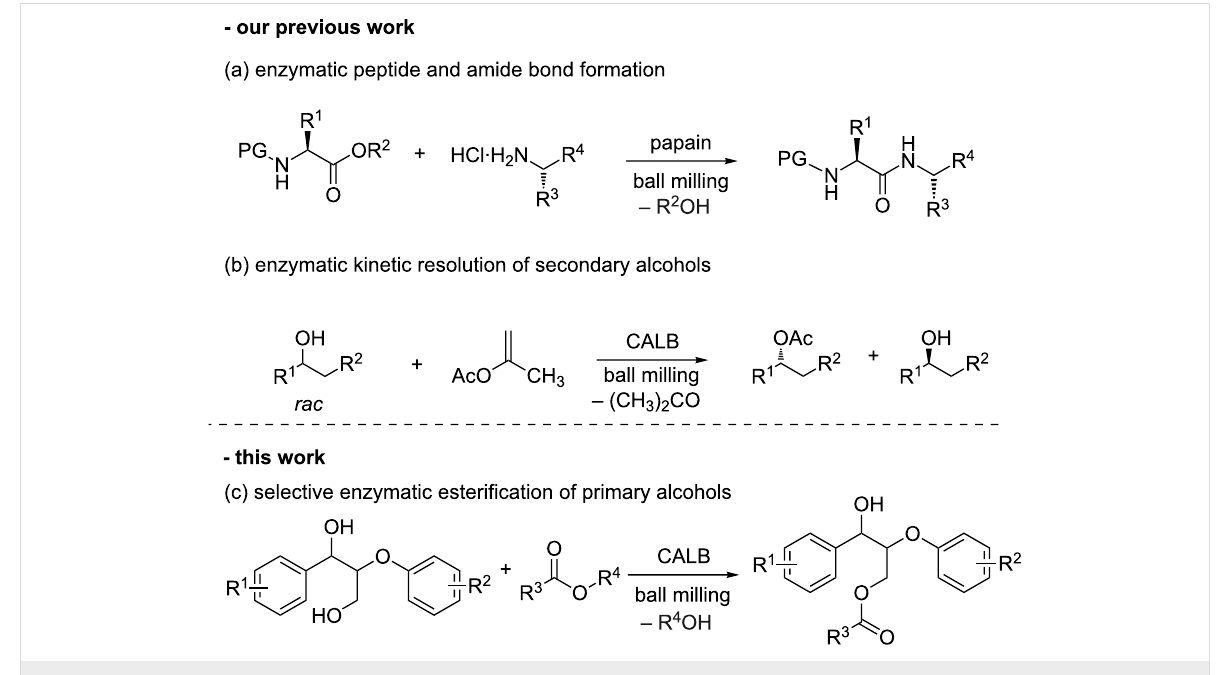
Scheme 1: Enzymatic reactions under ball milling